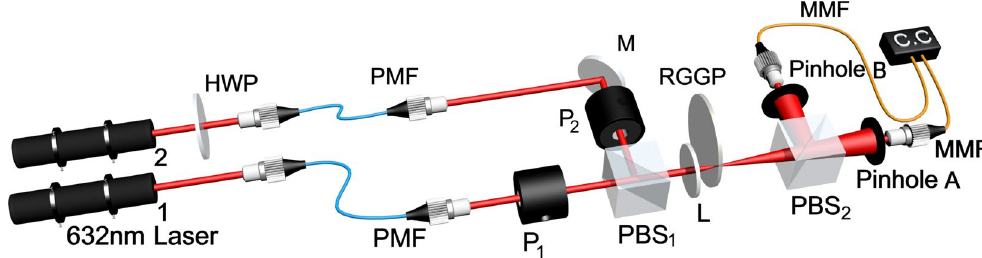
Figure 1. Experimental setup for measuring HBT effect without two-photon interference. Laser 1 and 2 are single-mode continuous-wave He-Ne lasers. HWP is a half wave plate. PWF is the single mode polarization- maintaining fiber. P 1 and P 2 are two polarizers, which are employed to keep the polarizations of two beams orthogonal. PBS 1 and PBS 2 are two polarization beam splitters. Two beams are combined into one beam at PBS 1 and the combined beam is focused by the lens (L) on the rotating ground glass plate (RGGP). PBS 2 splits the combined beam into two beams of light. MMF is the multi-mode fiber, which are employed to collect photons and transfer light to two single-photon detectors. It is measured by a HBT intensity